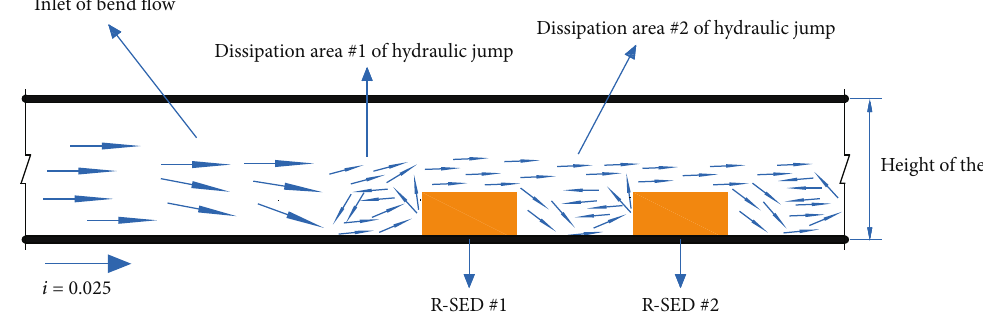
Figure 8: Schematic diagram of the energy dissipation process of the R-SEDs.